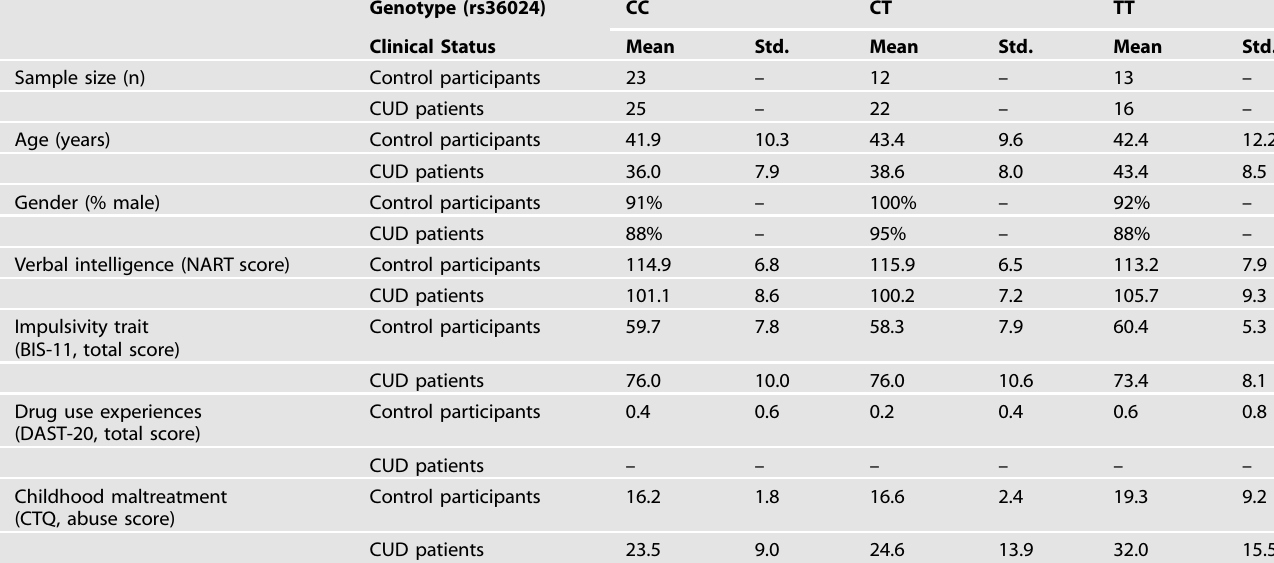
Table 1. Demographics, personality traits and clinical data [mean and standard deviation, (Std.)] presented by group and genotype. Genotype